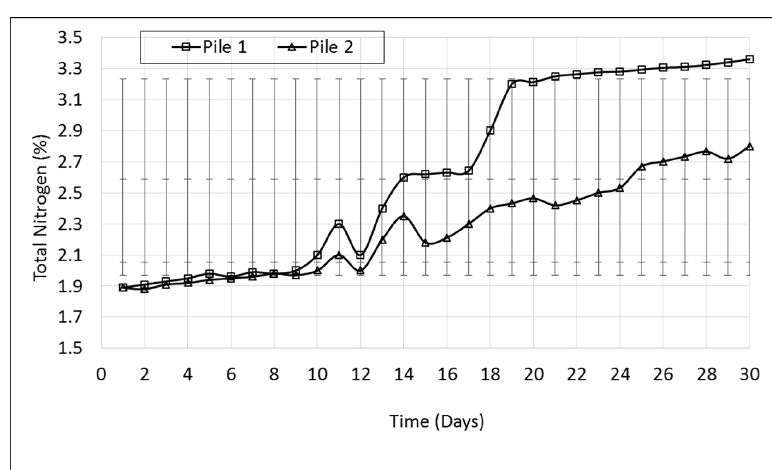
Figure 3. Total nitrogen variations during the study .